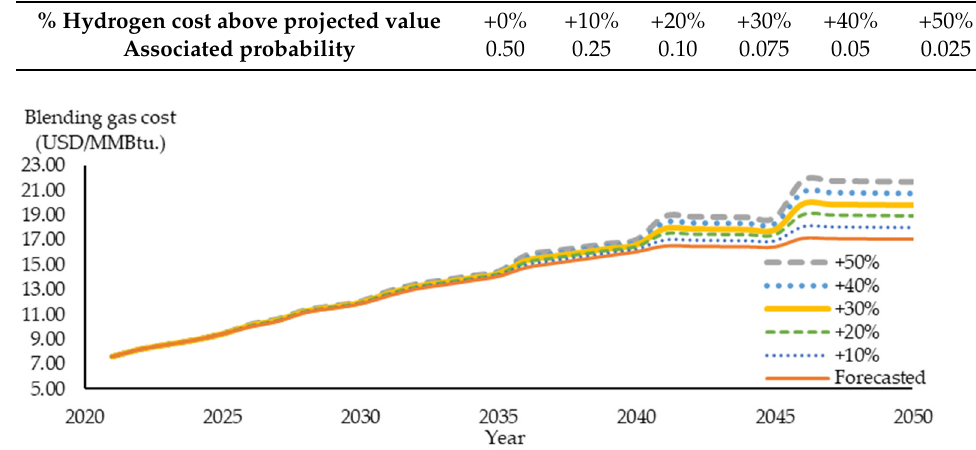
Figure 11. Percentage of hydrogen blended into the natural gas network. Table 2. Uncertainty of forecast hydrogen cost.